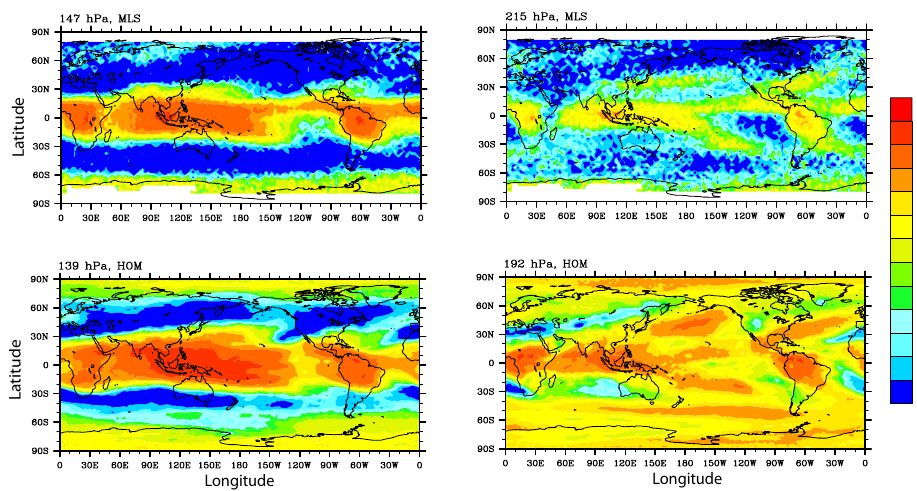
Fig. 7. Annual-average frequency of occurrence of ice supersaturation from MLS data (upper panel) for the HOM case (lower panel) at 147hPa (139hPa for the model) (left panel) and 215hPa (192hPa for the model) (lower